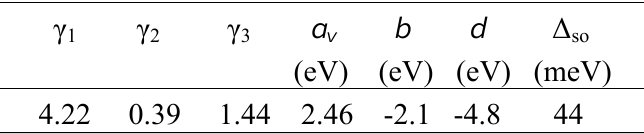
Table 1. Luttinger parameters, deformation potentials, spin-orbit split-off energy used in the calculation.